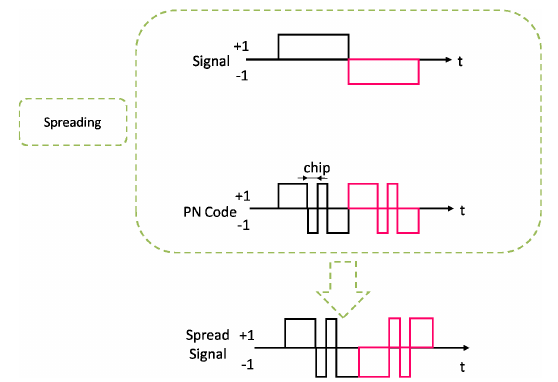
Figure 2: An Example of Spreading in DSSS